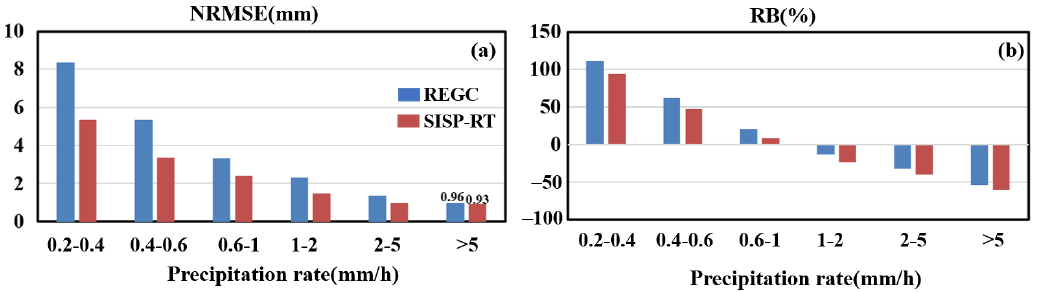
Figure 10. The ( a ) NRMSE and ( b ) RB of the REGC and SISP-RT at 0.1° spatial and hourly temporal resolution under di ff erent precipitation intensities.